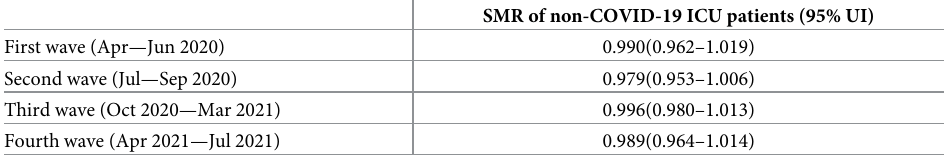
Table 2. Standardized mortality ratios of non-COVID-19 ICU patients in each wave of the epidemic.